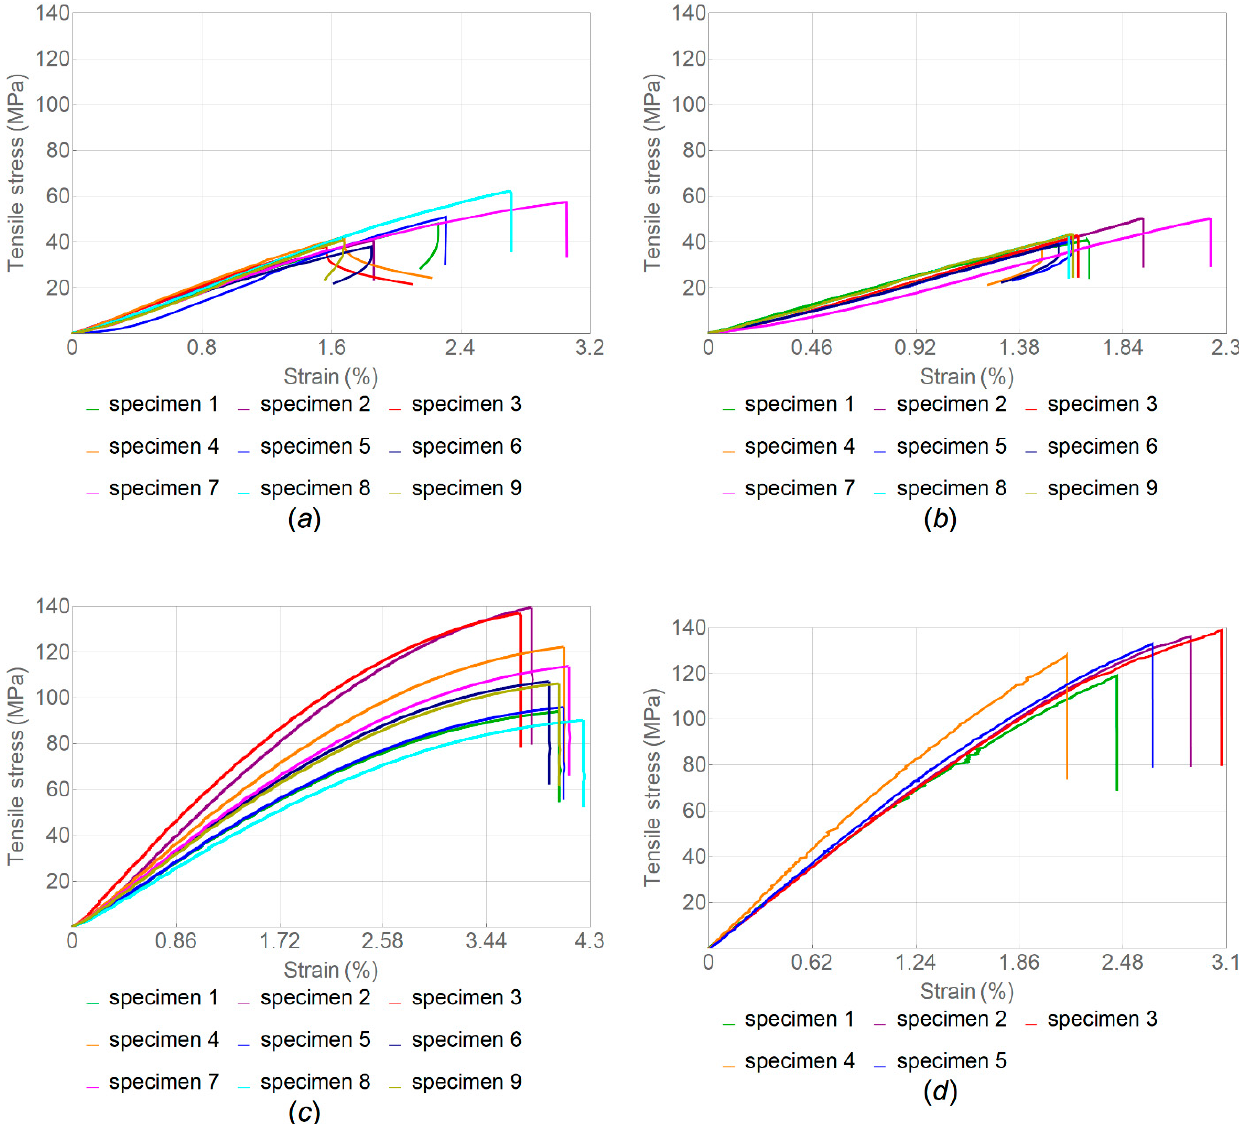
Figure 7. Tensile stress–strain curves for samples after heat treatment with different infill angle α :